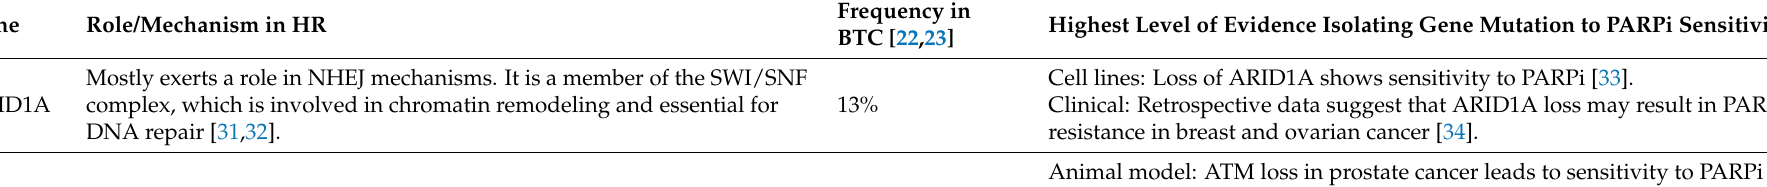
Table 1. Genes involved in HR, their frequencies in BTC, and a summary of evidence in support of sensitivity to PARPi when